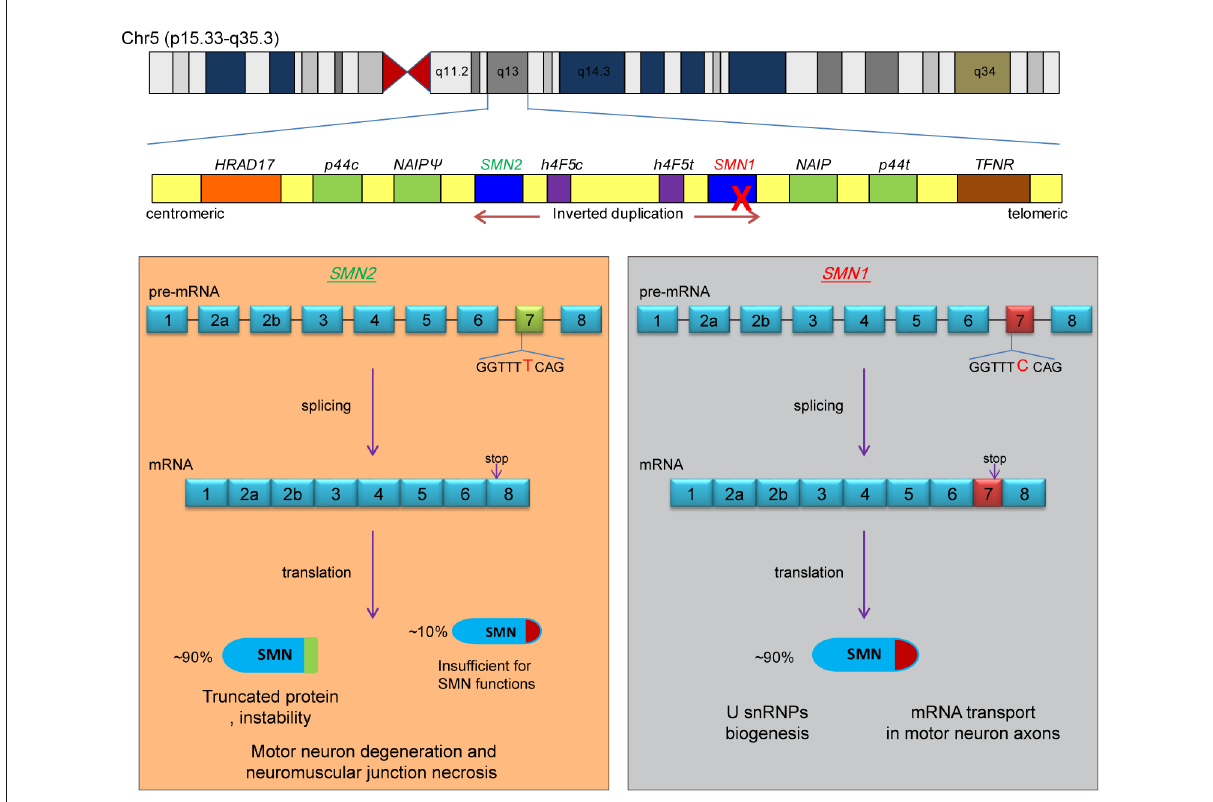
FIGURE1 Pathogenesis of SMA. The two causative genes of SMA are located in the q13 region of human chromosome 5, which is an inverted replication region, with SMN2 being located near the centromere and SMN1 being located on the telomeric side (upper part of the figure). The two boxes below represent the splicing process and protein products of the SMN1 and SMN2 genes, respectively. The dominant nucleotide (cytosine deoxyribonucleotide of SMN1 or thymine deoxyribonucleotide of SMN2 ) is marked in the figure, and the “stop” indicates the position of the stop codon. SMA develops because the SMN1 gene is completely inactivated and some full-length SMN protein expressed by SMN2 is insufficient to perform the relevant functions.